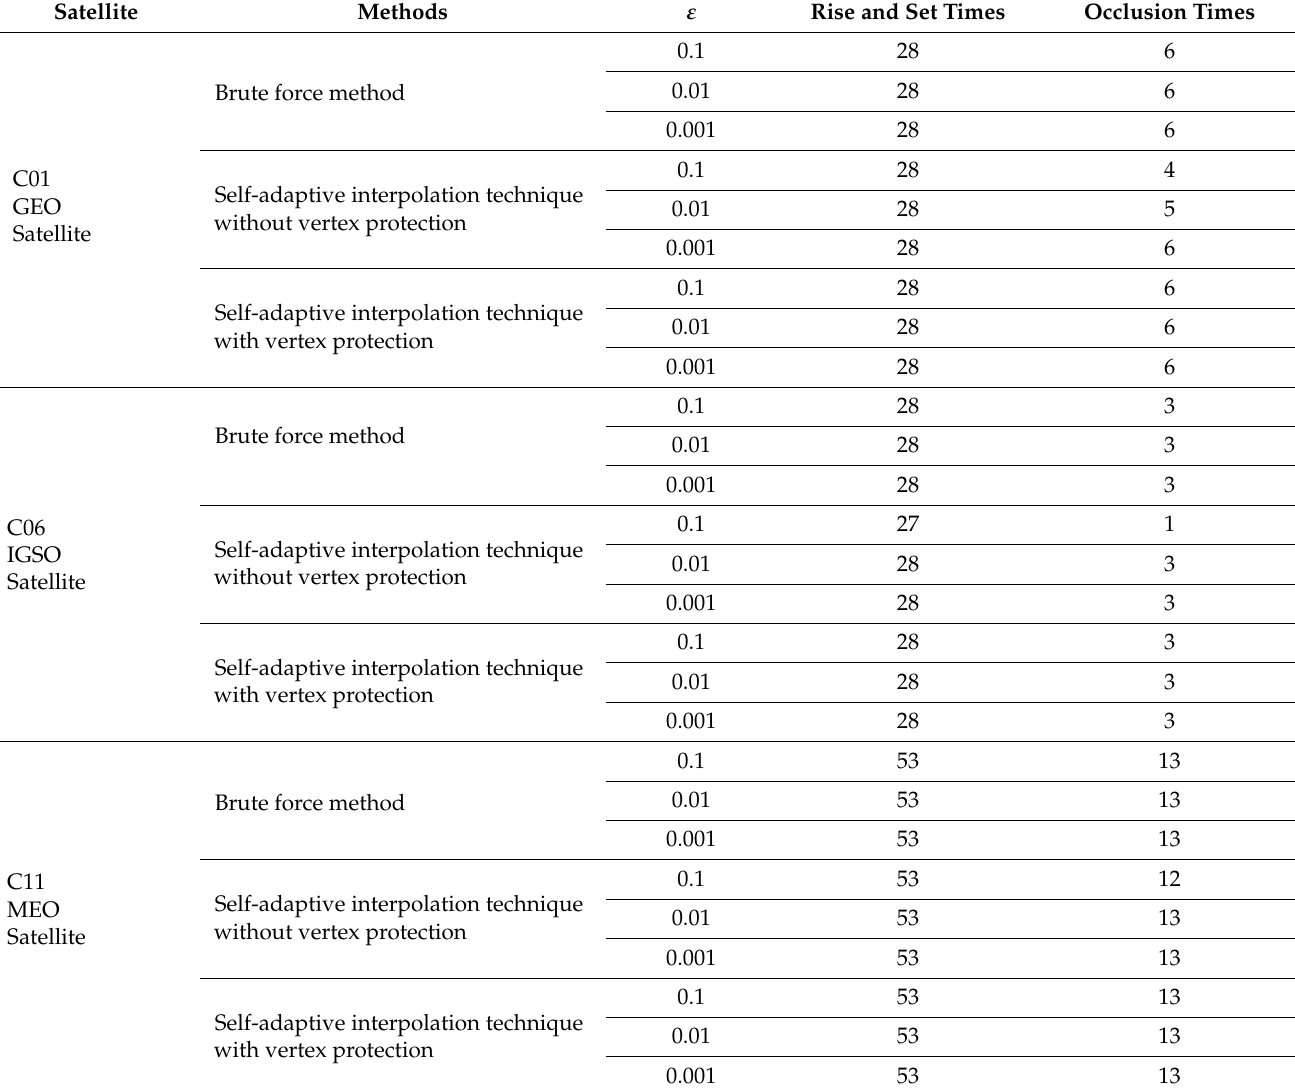
Table 1. Satellite visibility